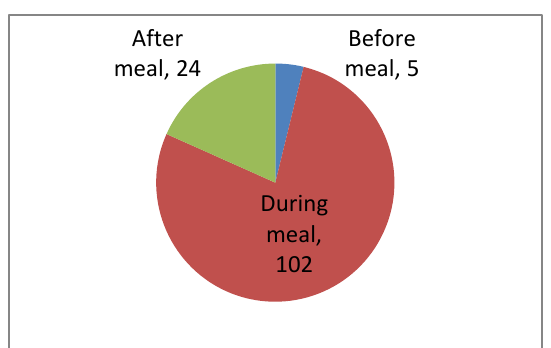
Figure 3 Habit of drinking water among the